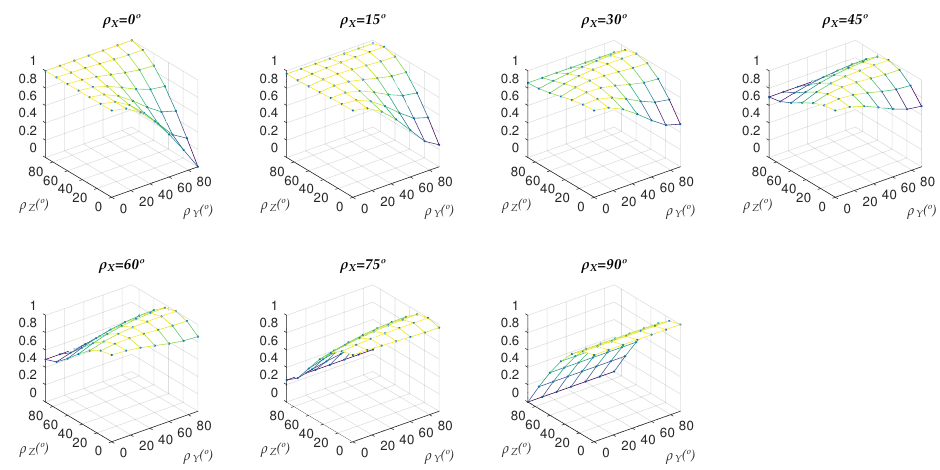
Figure 6. Deviationrate varying ρ Y and ρ Z , for ρ X = 0º, 15º, 30º, 45º, 60º, 75º, 90º.